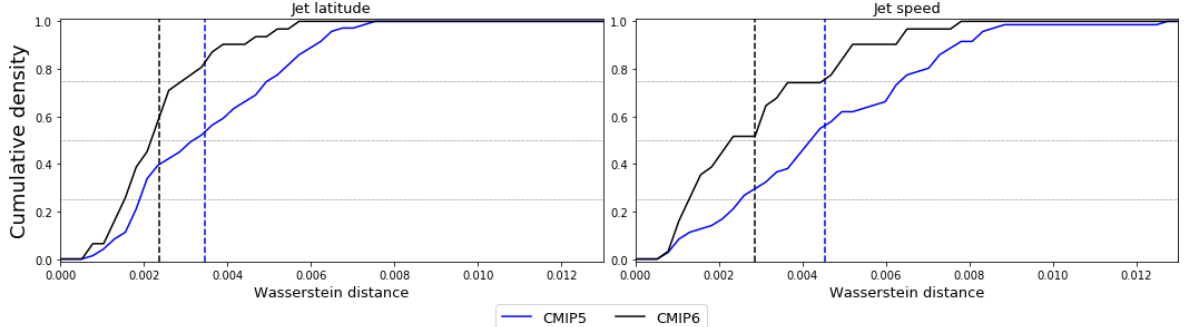
Figure 8. Cumulative density functions over model ensembles of the Wasserstein distance between model jet latitude and jet speed distribu- tions and the multi-reanalysis mean distributions. Dashed vertical lines indicate the ensemble mean